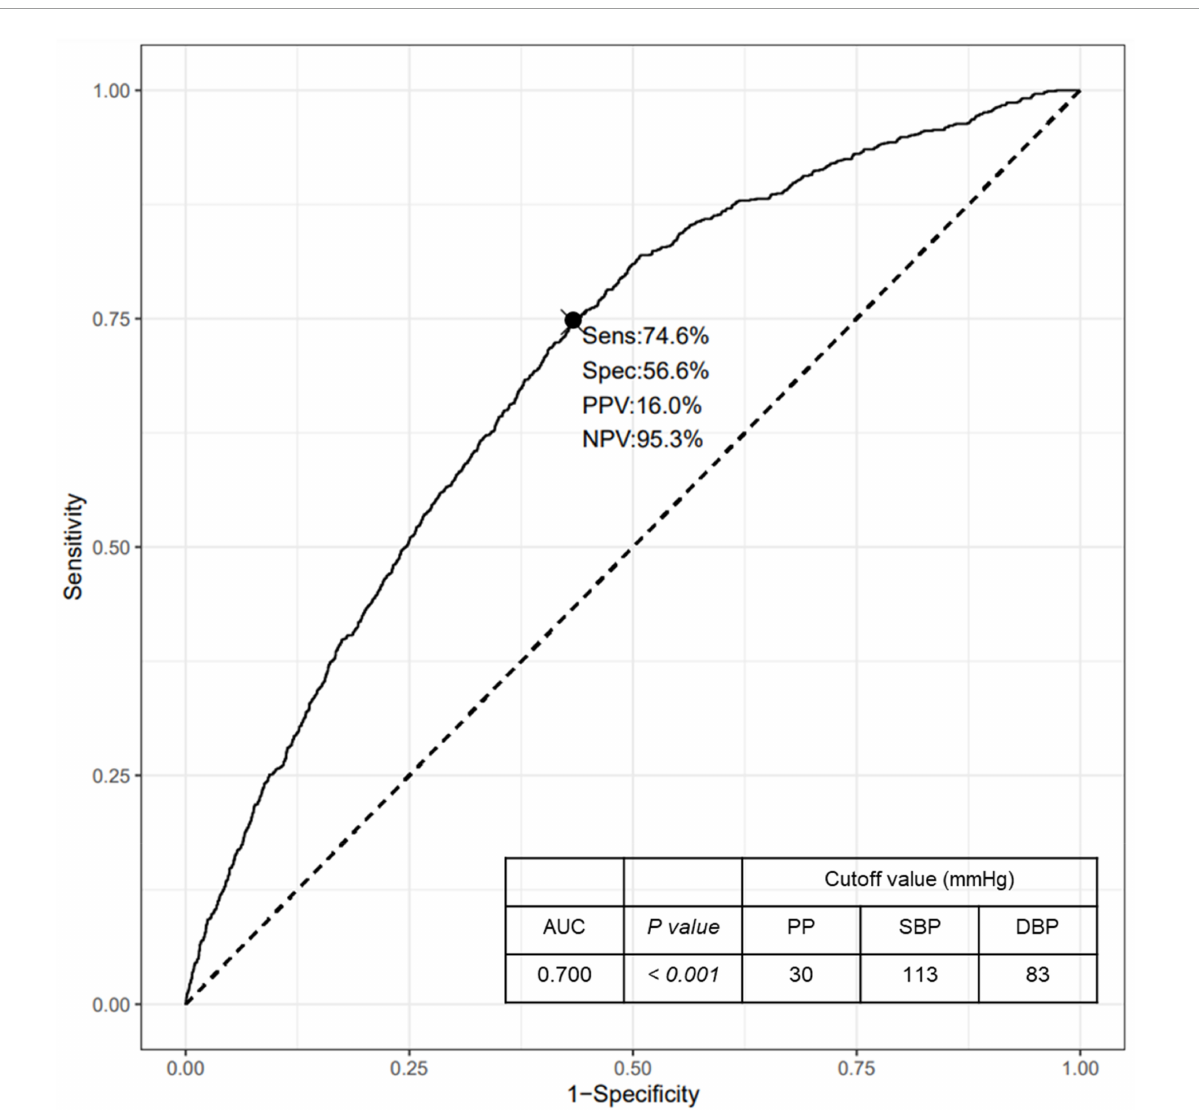
FIGURE2 ROC curve for the risk of RHF according to the PP levels. ROC, Receiver operating characteristic; RHF, renal hyperfiltration; PP, pulse pressure; Sens, sensitivity; Spec, specificity; PPV, positive predictive value; NPV, negative predictive value; AUC, area under the curve; SBP, systolic blood pressure; DBP, diastolic blood